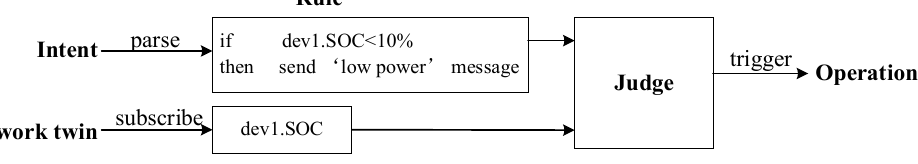
Figure 12. The execution flow of the conditional task.